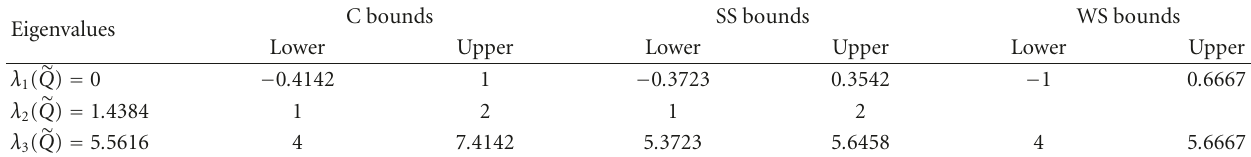
Table 1: C bounds, SS bounds, and WS bounds for Example 20.